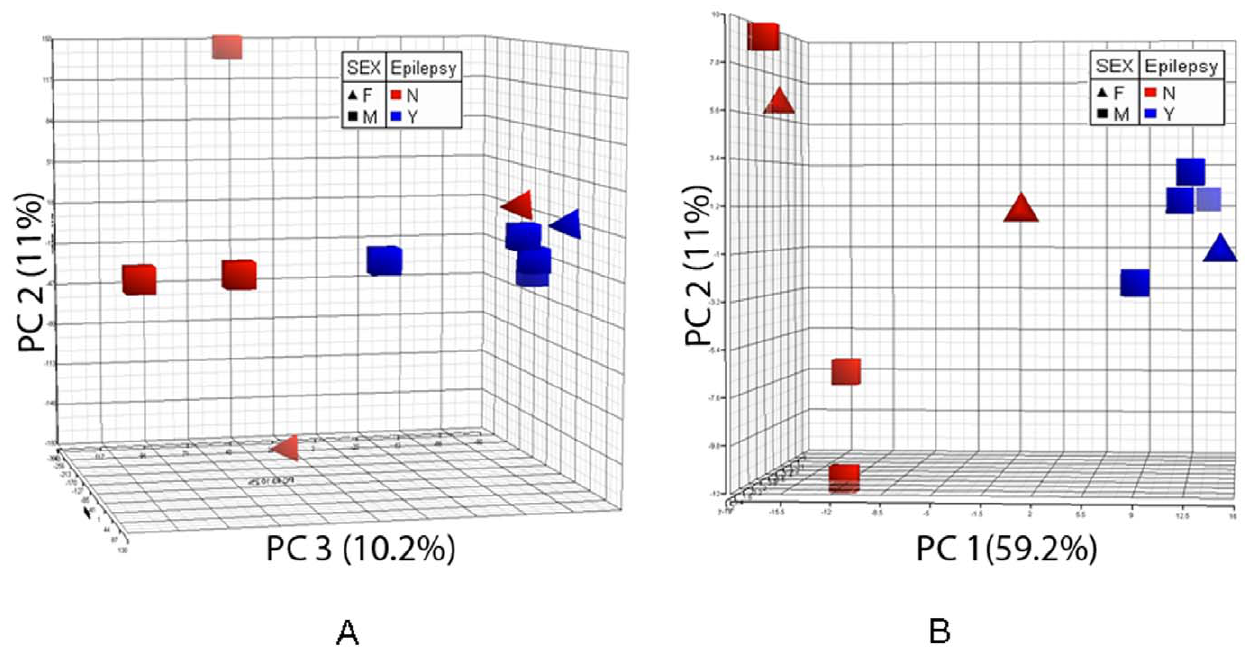
Figure 3. 3-D View of Principal Component Analysis showing distinguished clusters between epilepsy and non-epilepsy subjects. The PCA was performed based on all genes (A) and differentially expressed genes (B, DEGs, $ 2-fold change plus p # 0.05, T-test) between epilepsy and non-epilepsy patients. Patients with or without epilepsy are represented by different colors, i.e., blue for epilepsy (Y); red for non-epilepsy (N). The gender is represented by different symbols, i.e., square for male (M); triangle for female (F).